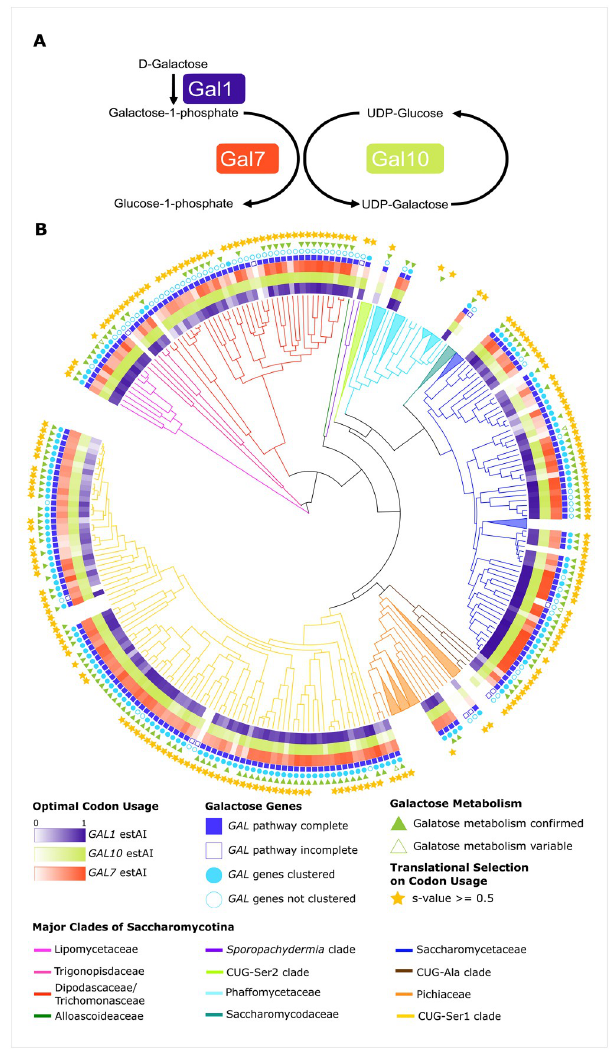
Fig 1. The GAL pathway and the distribution of galactose metabolism, GAL genes, and preferred codon usage across the Saccharomycotina. (A) The 3 enzymes of the GAL pathway metabolize galactose into glucose-1-phosphate, which can then enter glycolysis after being converted into glucose-6-phosphate. (B) Various features of galactose metabolism plotted on a phylogeny of the budding yeast subphylum Saccharomycotina; the 12 major clades of the subphylum are color coded. The presence and codon optimization (measured by estAI) of the 3 GAL genes are represented in the inner 3 rings. Clades with 3 or more species without a complete GAL pathway were condensed and are shown as triangles; for the full tree, see S1 Fig. The GAL clusters in the Dipodascaceae/Trichomonascaceae, Pichiaceae, and Phaffomycetaceae were recently found to have likely originated from horizontal gene transfer events from the CUG-Ser1 clade [72]. We did not identify any GAL genes from species in the CUG-Ser2 clade or the family Saccharomycodaceae. In every other major clade examined, we identified complete and clustered occurrences of the GAL pathway (filled-in blue squares and circles, respectively.) High codon optimization (darker colors) in the GAL pathway is not restricted to any one major clade. The ability to metabolize galactose (filled-in green triangle) was assessed either experimentally in this study or taken from the literature. In some instances, where only literature data were available, there were conflicting or variable reports of galactose metabolism (5 species; empty green triangles). The majority of species in the Saccharomycotina have also been shown to have genome-wide selection on codon usage (denoted by the yellow stars) [59]. Species names and ecological information can be found in S1 Fig and Table A S1